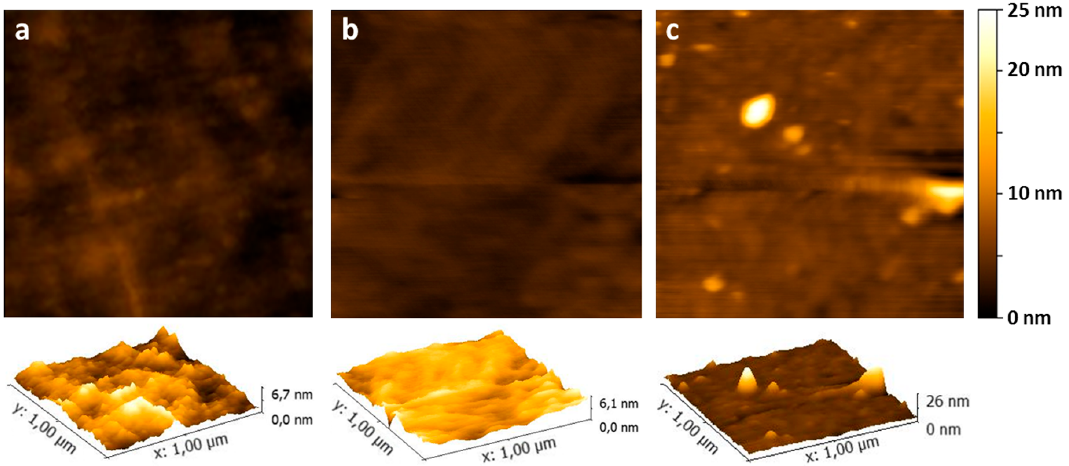
Figure 6. 2D and 3D AFM images of the 1 µ m × 1 µ m area of the pristine sPEEK membrane ( a ); the dry sPEEK membrane after reacidification and hydrothermal treatment ( b ) and the membrane with Au-3MPS ( c ).